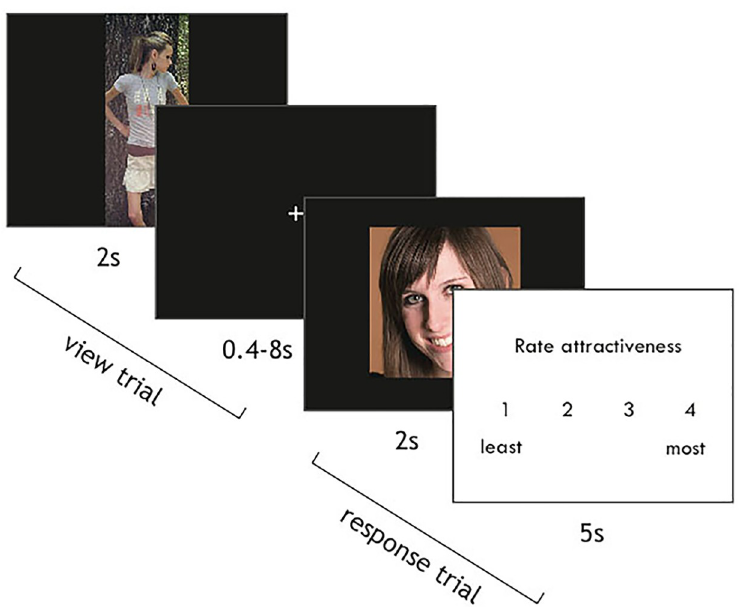
Fig 1. fMRI task paradigm. Participants viewed images of faces, bodies with faces, and scrambled images for 2s each. On most trials, image presentation was followed by a variable length inter-trial interval. On a subset of trials, participants were given 5s to rate the attractiveness of each image using a button